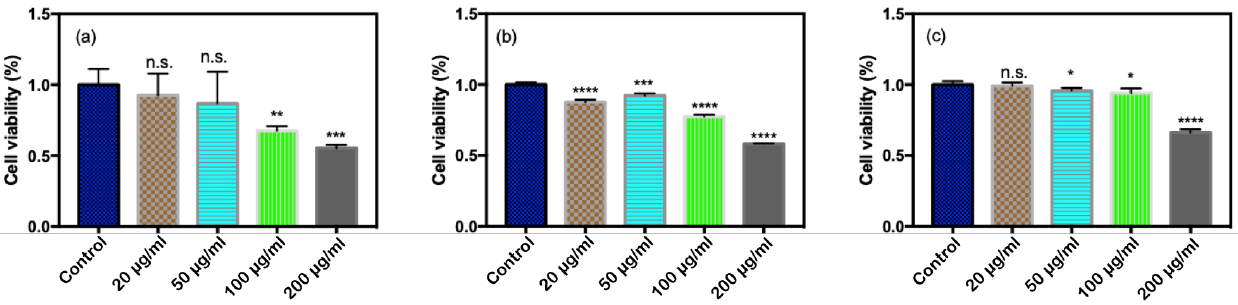
Figure 3. Survival rate of E. coli exposed to different concentrations of CQDs measured by MTT method. ( a ) 24 h, ( b ) 48 h, and ( c ) 72 h (n.s. p > 0.05, * p < 0.05, ** p < 0.01, *** p < 0.001, and **** p < 0.0001).